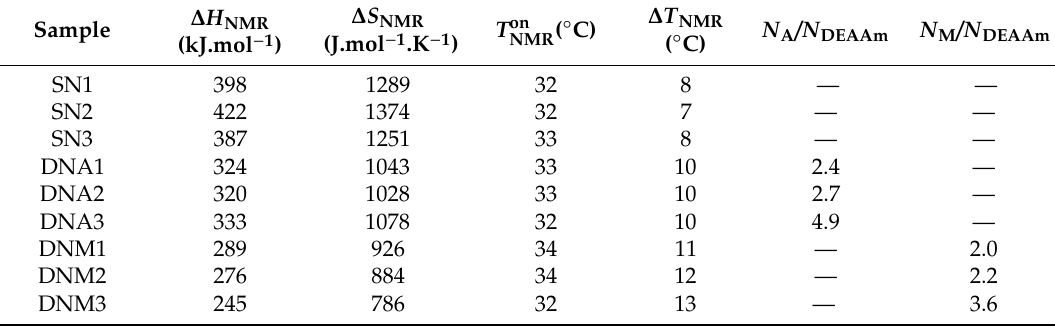
on , width of transition ∆ T NMR and molar ratios of AAm NMR